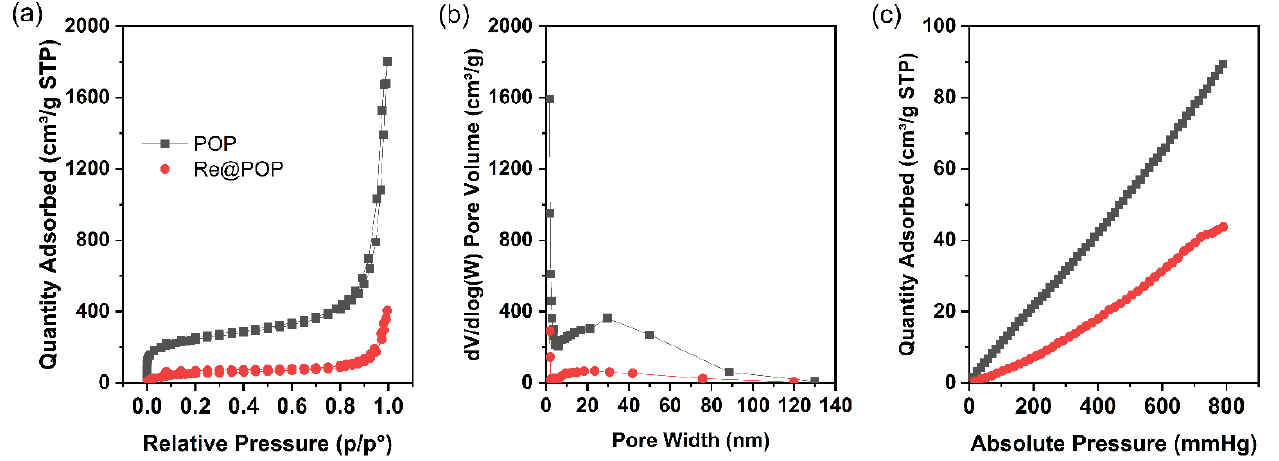
Figure 9. ( a ) N 2 physisorption isotherm and ( b ) BJH pore volume and collected at 77 K on POP and